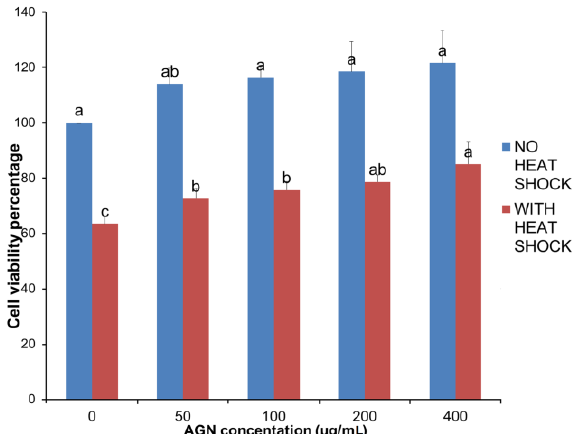
Figure 1. Angelica gigas Nakai root hot water extract promoted cell proliferation on cells subjected to normal incubation temperature (37°C) and alleviates heat shock by both cytotoxicity prevention and dose dependent cell proliferation among 3T3-L1 cells incubated for 24 hours. The results are expressed as mean±standard deviation. Bars with different superscript are significantly different (p<0.05).